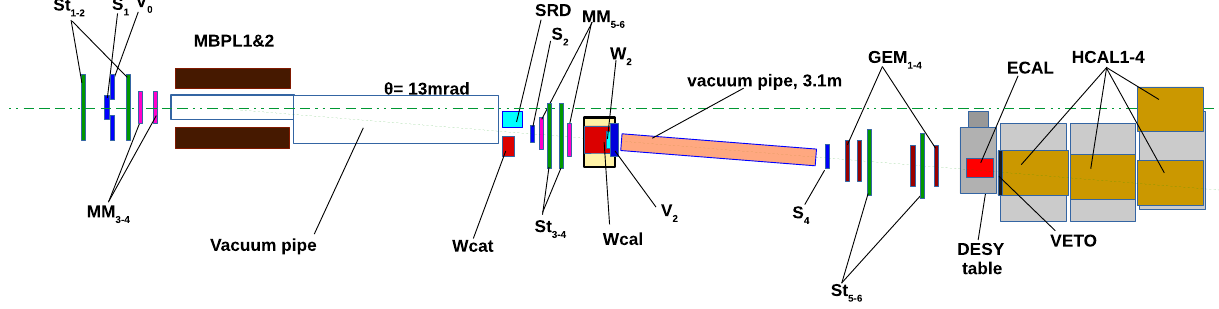
Fig. 2 The setup used in 2018 to search for X 17 → e + e − decays of the bremsstrahlung X 17 produced in the reaction eZ → eZ + X 17 of the 150 GeV electrons incident on the active WCAL